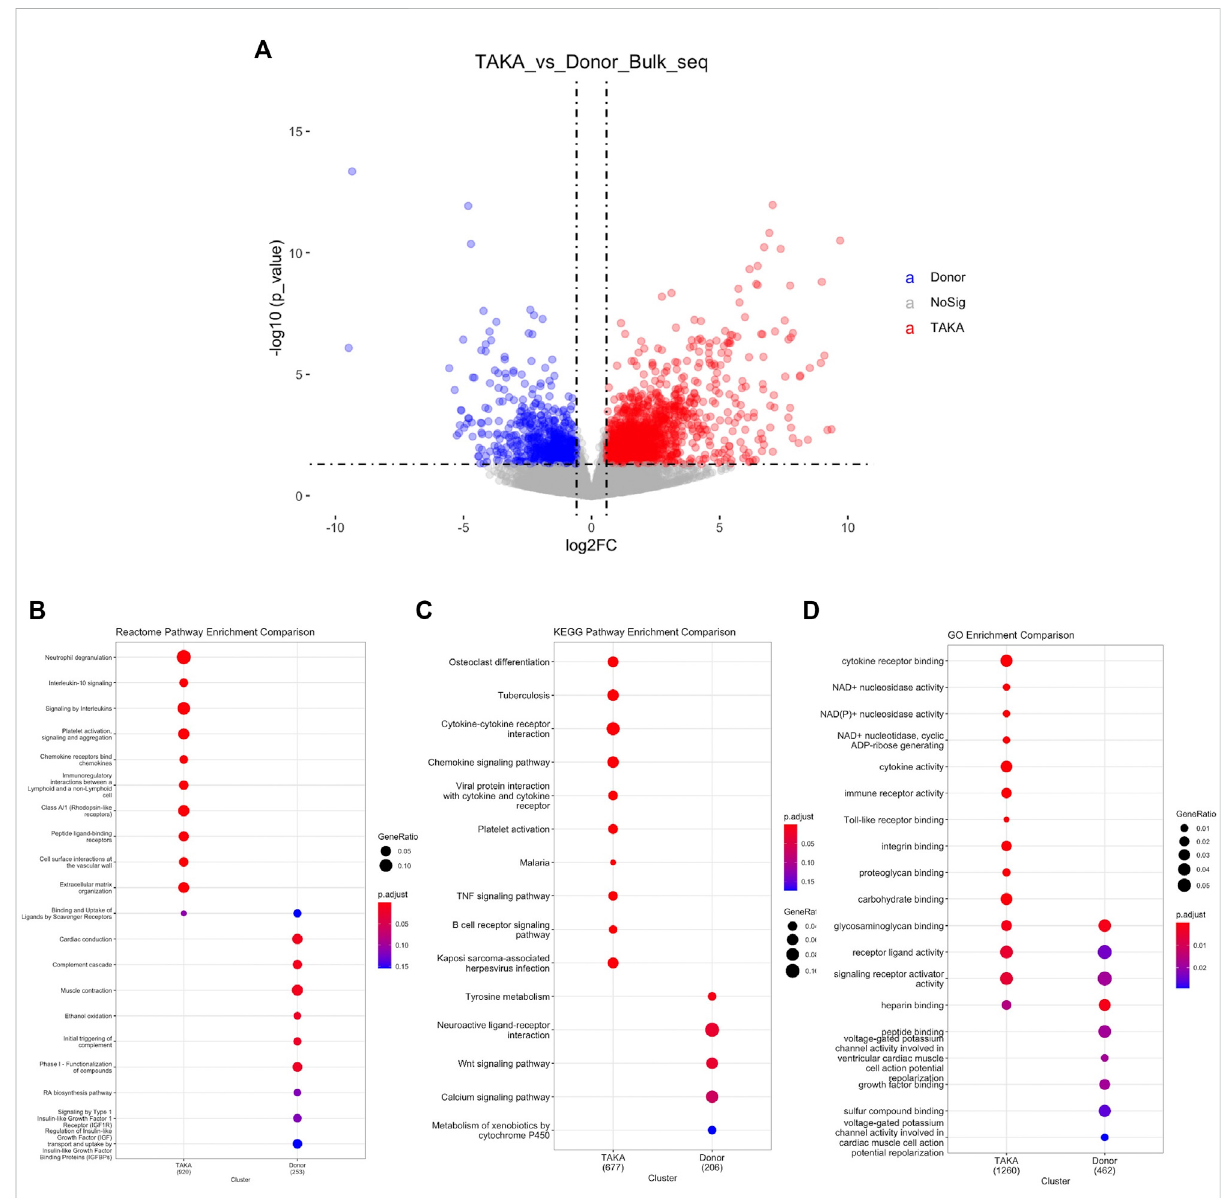
FIGURE 2 Analysis of differential expressed genes. (A) Volcano plot displaying differential expressed genes. 1897 transcripts were signi fi cantly differently ( p < 1e-05 and Log 2 FC > 1) expressed between the TA and donor group. Pathway analysis was perfomed in (B) Reactome pathway comparison (C) KEGG pathway enrichment comparison and (D) GO enrichment